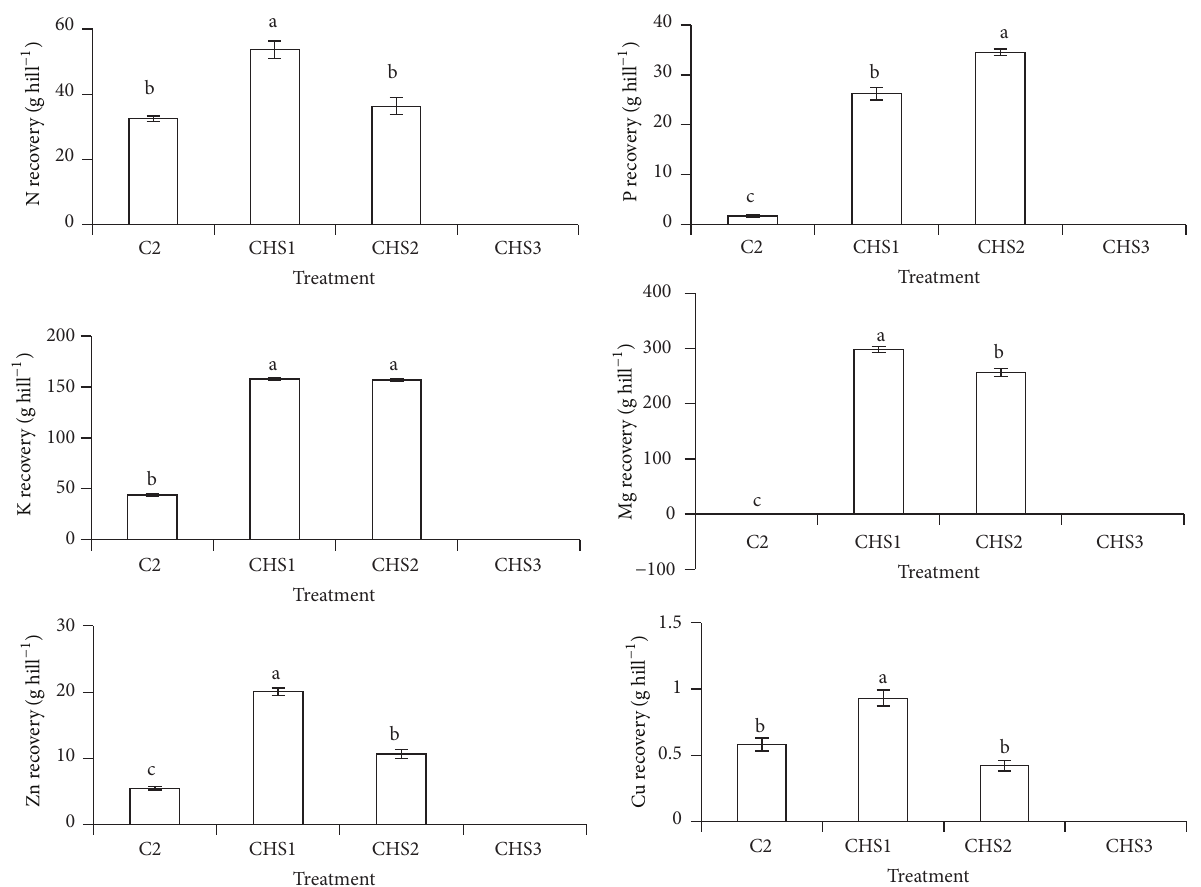
Figure 6: Treatments (C1: soil alone, C2: soil + complete fertilization, CHS1: soil + complete fertilization + 20 g rice straw compost + 2 g sawdust ash, CHS2: soil + complete fertilization + 40g rice straw compost + 4g sawdust ash, and CHS3: soil + complete fertilization + 60 g rice straw compost + 6 g sawdust ash) effect on rice plant N, P, K, Mg, Cu, and Zn recovery at 90 days after seeding. Different alphabets indicate significant difference between means using Tukey’s test at 𝑃 ≤ 0.05 . The error bars are the ± standard error of quadruplicates. content in compost and compost rate can cause an